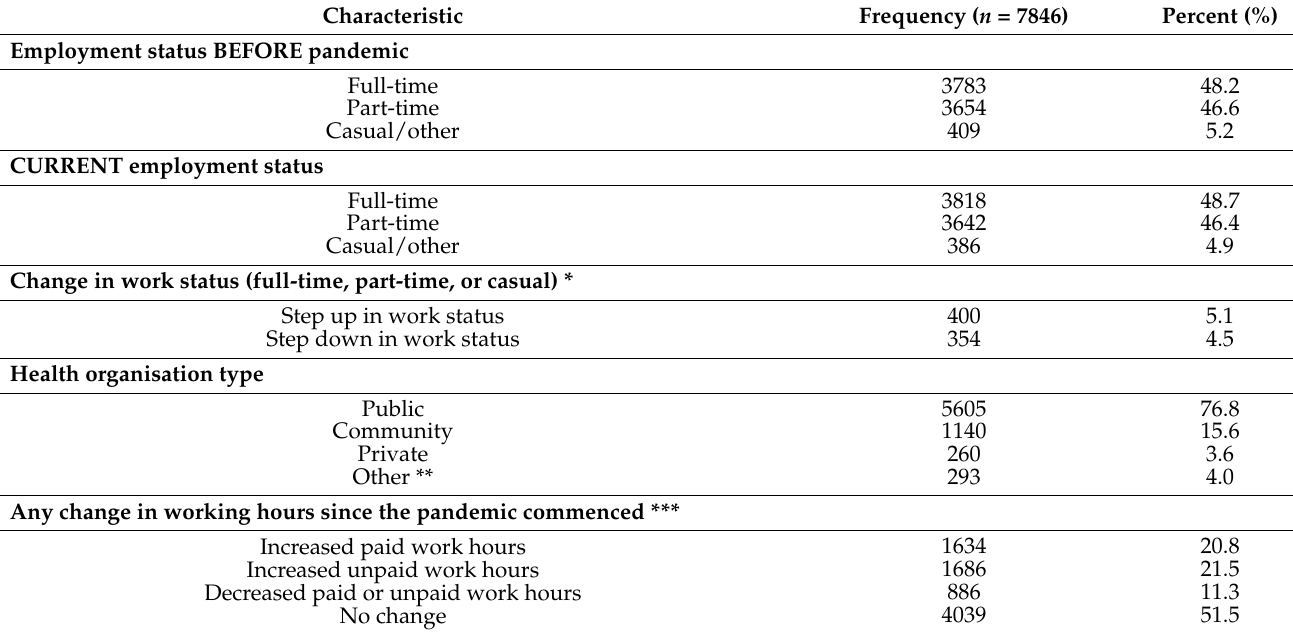
Table 2. Occupational disruptions and perception of